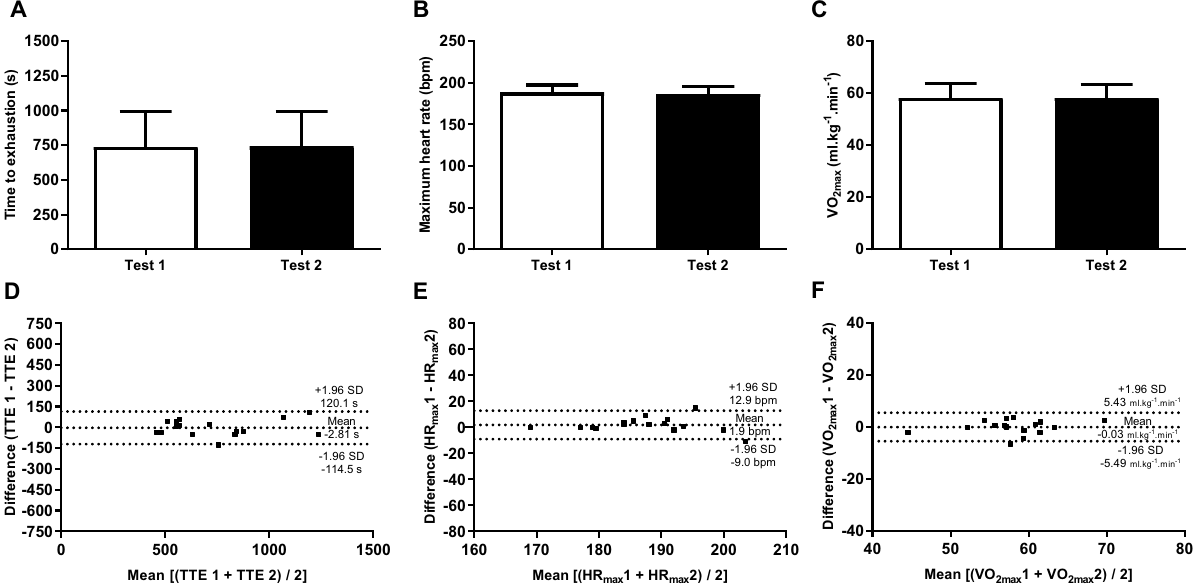
Figure 3. Comparison and Bland–Altman plots between the time to exhaustion ( A and D ), maximum heart rate ( B and E ), and maximum oxygen uptake ( C and F ) of the athletes performance in the reproducibility phase of the study (n =